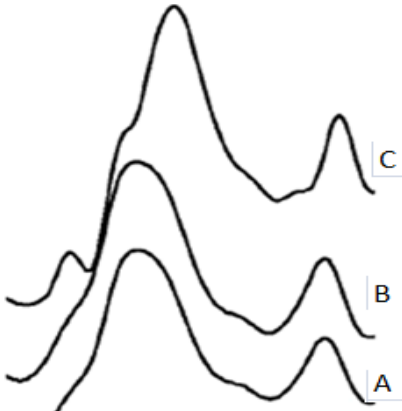
Figure 1. Comparative HPLC chromatogram A. diethylnicotinamide ; B. sodium pseudocumene sulfonate ; C. sodium thiocyante .